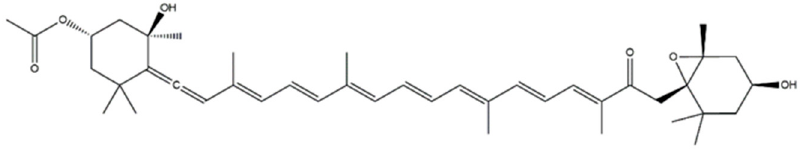
Figure 3. Structure of fucoxanthin.